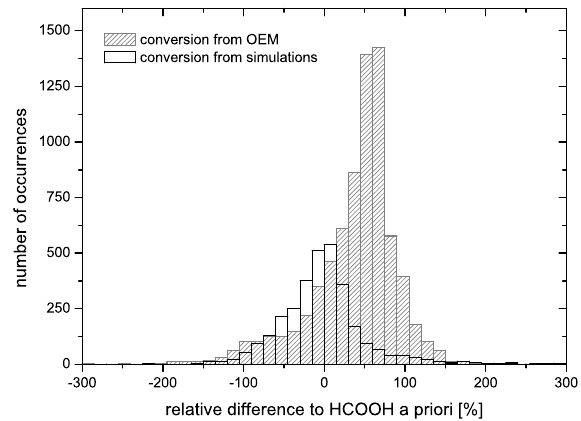
Fig. 9. Histograms of the relative differences between the simu- lated total columns of HCOOH and the HCOOH total columns ob- tained from brightness temperature differences. The gray histogram is derived from the conversion which uses OEM retrievals and the black one corresponds to the conversion obtained with simulated data. The latter, which is much less biased is used to obtain the global distributions (see Sect.